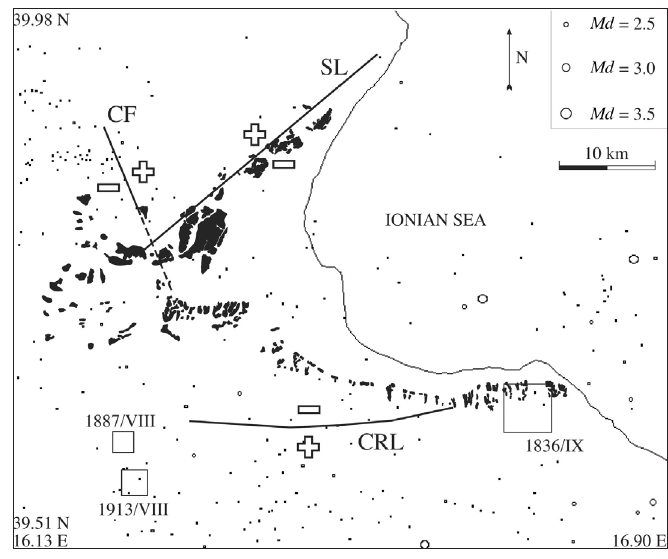
Fig. 9. Seismicity, major faults (see text) and marine terraces in the study area. The map shows historical events with intensities ≥ VIII MCS since 1000 A.D. from Boschi et al. (2000), and the 1985-2000 Md ≥ 2.0 instru- mental earthquakes from the bulletin of the INGV seismometric network. Fault abbreviations as in fig. 1; the dashed line is the CF’s southern continuation hypothesized by Cinti et al. (1997). The relative sense of dis- placement across the faults is also